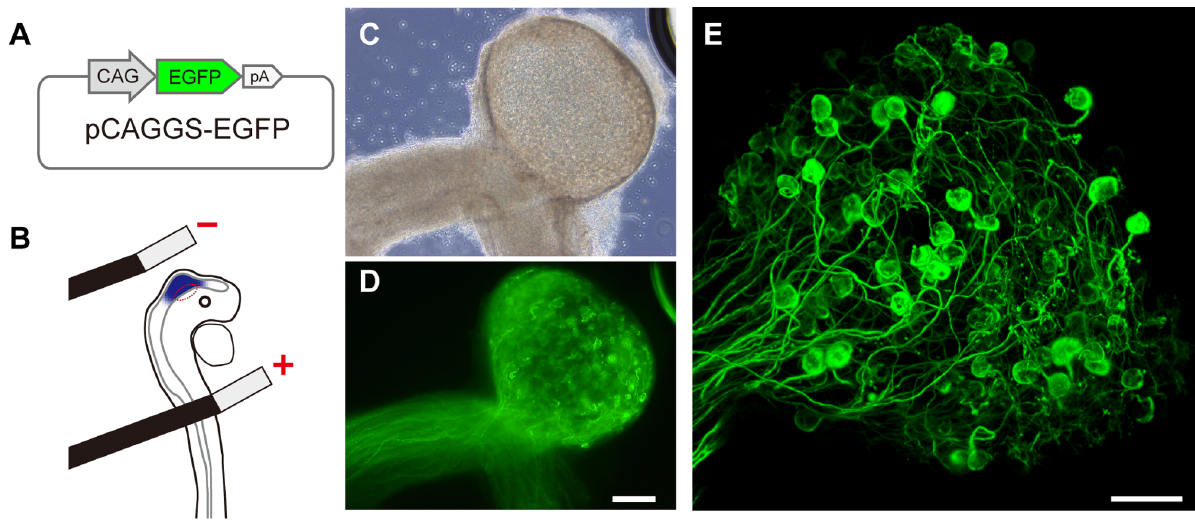
Figure 1. Genetic manipulation of presynaptic neurons innervating chick ciliary ganglion using inovo electroporation method. A , Schematic structure of pCAGGS-EGFP plasmid vector. B , Position of bipolar electrodes placed on the midbrain region (red ellipse) of E2 embryo. C and D , Bright-field and EGFP fluorescent images of isolated CG with oculomotor nerve of E14 embryo. E , A compiled image of a CG (E14) under confocal microscopy. Scale bars: 200 m m for D and 100 m m for E .